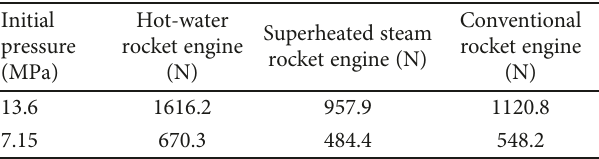
Figure 10: Basic working principle of the hot-water Table 3: The thrust of the hot-water rocket engine, superheated steam rocket engine, and conventional rocket engine [50].